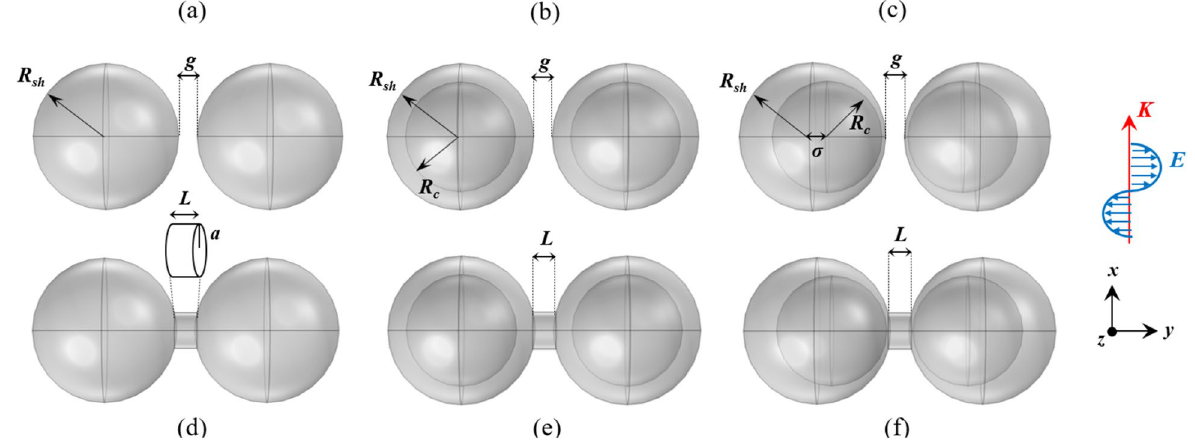
Figure 1. Schematic diagram of (top) dimers and (bottom) bridged dimers with different geometries including ( a ) spherical dimer—SSD, ( b ) core-shell dimer—CSD, ( c ) nanoegg dimer—NED, ( d ) spherical bridged dimer— SSBD, ( e ) core-shell bridged dimer—CSBD and ( f ) nanoegg bridged